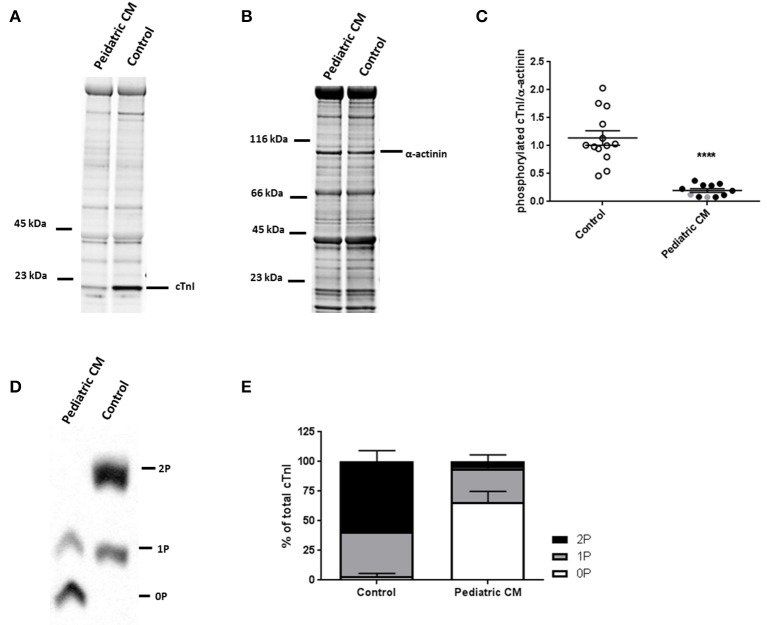
Hypophosphoryalation in pediatric CM compared to controls. (A) ProQ staining identifying phosphorylated proteins of pediatric CM and control samples. (B) Corresponding SYPRO staining identifying proteins of pediatric CM and control samples. (C) cTnI phosphorylation was significantly lower in pediatric CM (N = 11) compared to controls (N = 13, p < 0.0001). (D) Phostag showed separation of non-, mono-, and bisphosphorylated cTnI. (E) While controls (N = 11) showed predominantly mono- and bisphosphorylated cTnI, pediatric CM samples (N = 11) showed mostly non-phosphorylated cTnI. Measurements obtained from samples derived from patients with non-compaction cardiomyopathy are indicated in gray. ****p < 0.0001 vs. controls.